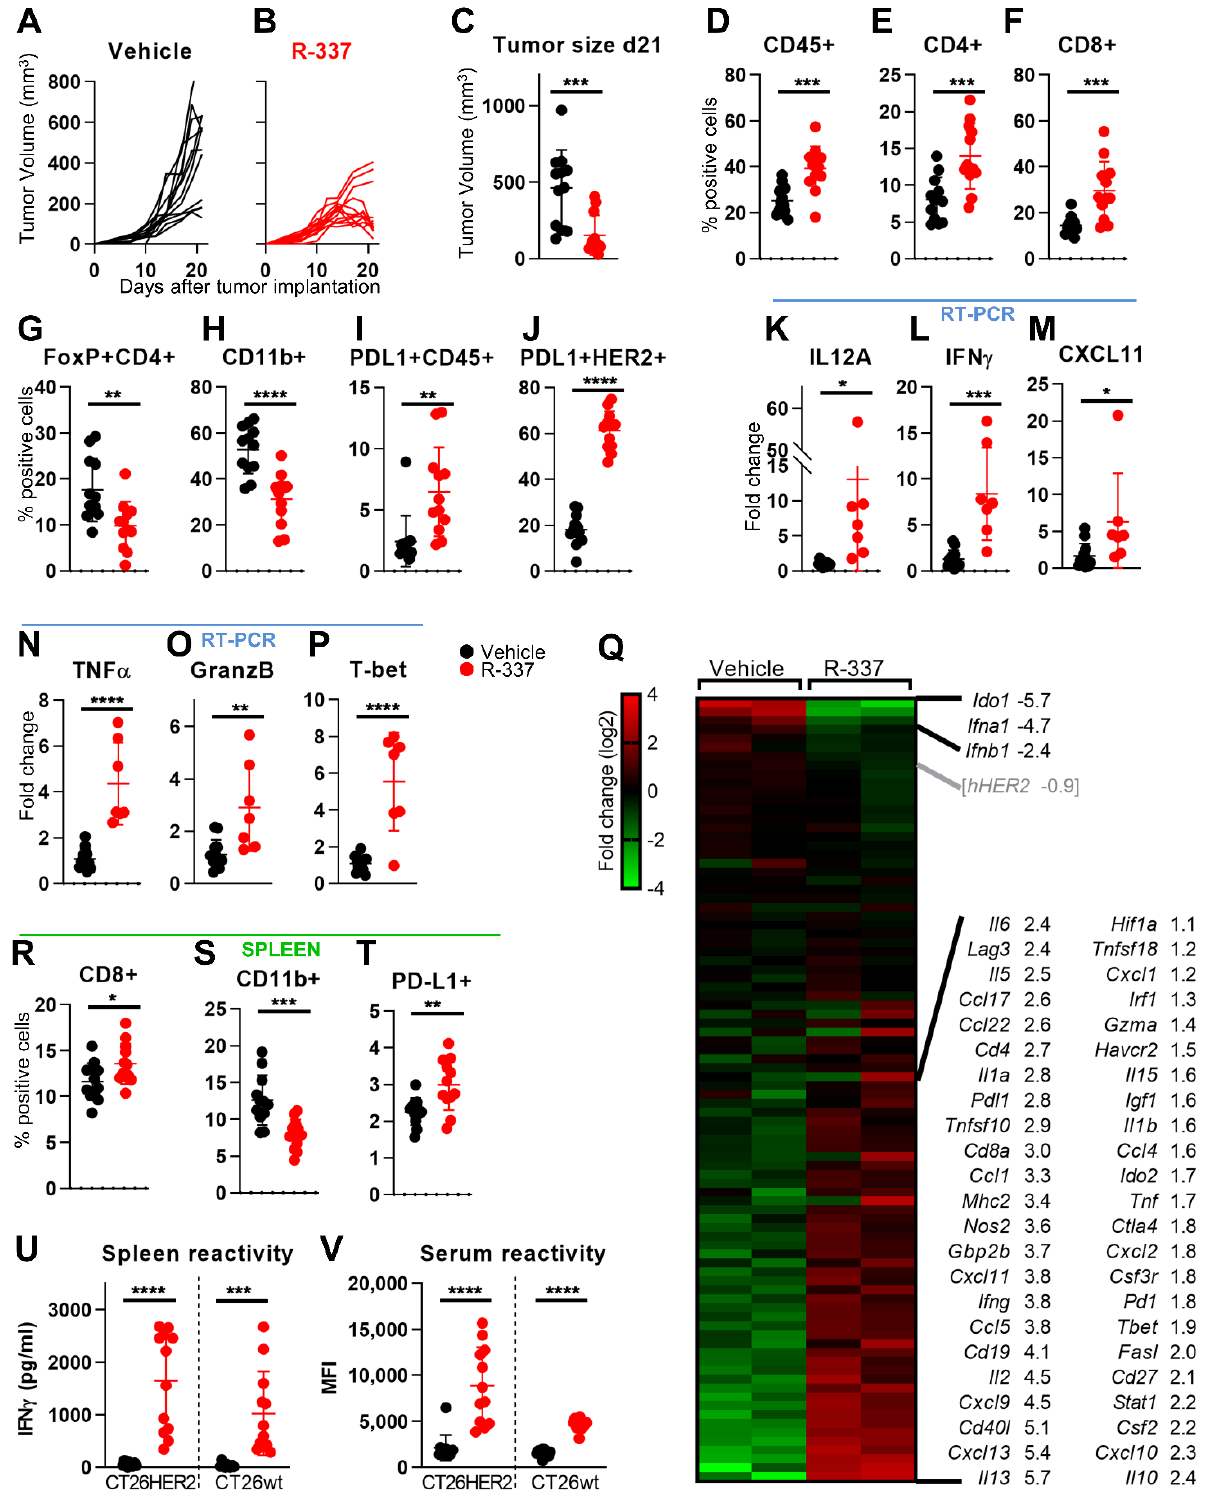
Figure 4. Immune modifications to TME and spleen induced by intratumoral R-337 monotherapy. ( A , B ) Kinetics of tumor growth in HER2-TG BALB/c mice treated with vehicle ( A ) or R-337 ( B ), according to the schedule reported in Figure 3A (3 injections of 5 × 10 7 PFU). ( C ) Tumor volumes at d 21. ( D–H ) Immune cell populations in tumors. Samples were prepared as described in Figure 2. For each sample, 2 × 10 6 cells were blocked with α -CD16/32 Ab (clone 93), and then reacted with the antibodies CD4-FITC (clone GK1.5), CD8a-PE (clone 53-6.7), CD45-Percp-Cy7 (clone 30-F11), FoxP3-PE (clone 150d/e4), and CD11b-FITC (clone M1/70). Data were acquired on BD C6 Accuri. CD4 (CD4+ cells), CD8 (CD8+ cells), and myeloid cells (CD11b+ cells) were gated on CD45+ subpopulation. Tregs (FoxP3+CD4+) were gated on CD4+ population. ( I , J ) PD- L1 expression in immune cell population or tumor cells in explanted tumors. Samples prepared as detailed above were reacted with the antibodies: CD45-Percp-Cy7 (clone 30-F11), PD-L1-APC (clone MIH5), and HER2-APC (clone 9G1D4B10).